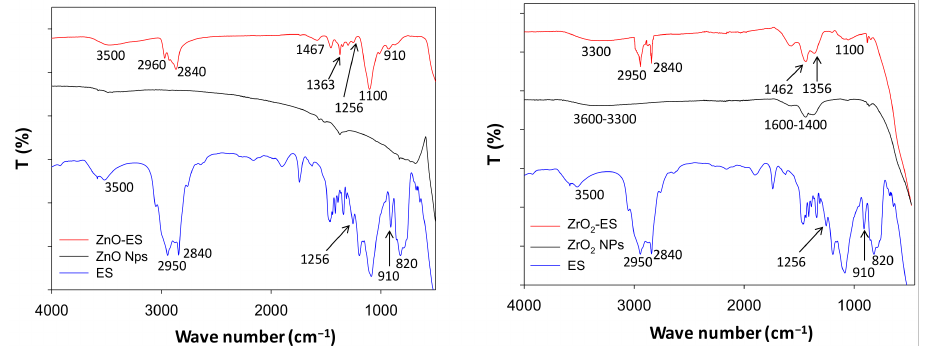
Figure 3. Fourier transform infrared (FTIR) spectra (attenuated total reflectance (ATR) mode) of NPs and GPTMS-capped NPs: ZnO ( left ) and ZrO 2 ( right ); spectrum of 3- glycidoxypropyltrimethoxysilane (ES) is also reported for